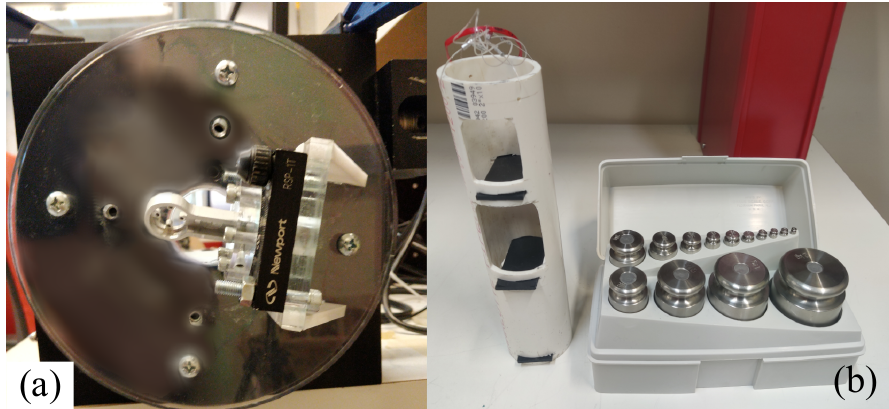
Figure 14. The loading materials needed to characterize, calibrate, and validate a 3-DOF sensor: ( a ) 2-stage rotary table setup for configuring 3D angular orientation of sensor; ( b ) set of loading weights (ranging from 1g to 2kg) and loading tube for holding weights and providing line of tension from the sensor.